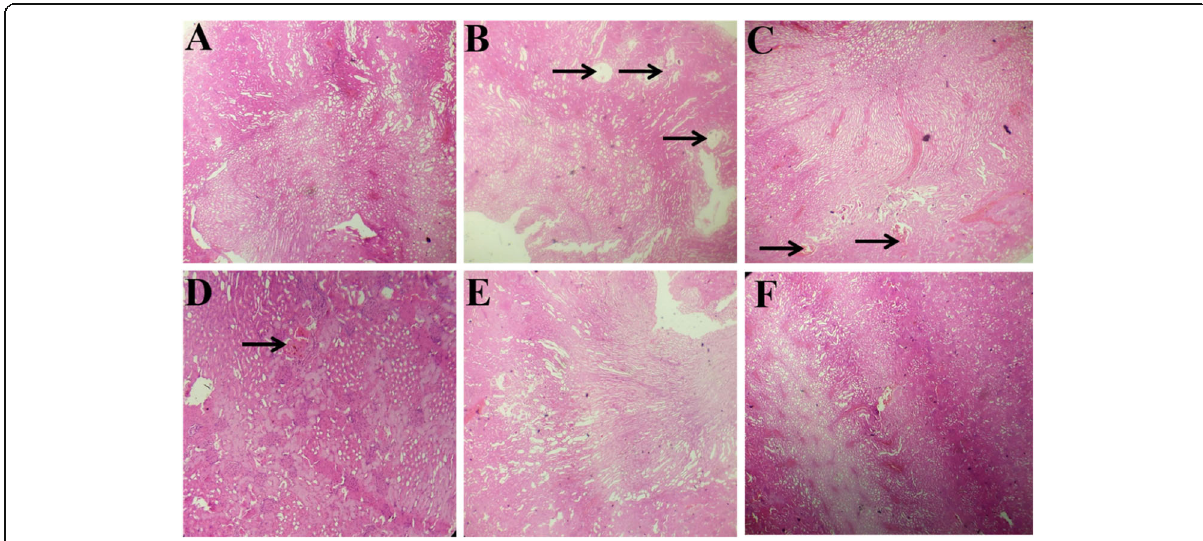
Fig. 5 Histological photomicrographs of kidney samples from Wistar rats with Lead acetate-induced toxicity and treated with PLEE (Mag., X100). A (Control group): No visible lesions seen; B (Lead only): Tubular sections appear greatly enlarged; C (Lead + PLEE (1): Moderate congestion of the renal cortex; D (Lead + PLEE (2): Mild to moderate congestion at the renal cortex; E (PLEE (1) No visible lesions are seen; F (PLEE (2): No visible lesions are